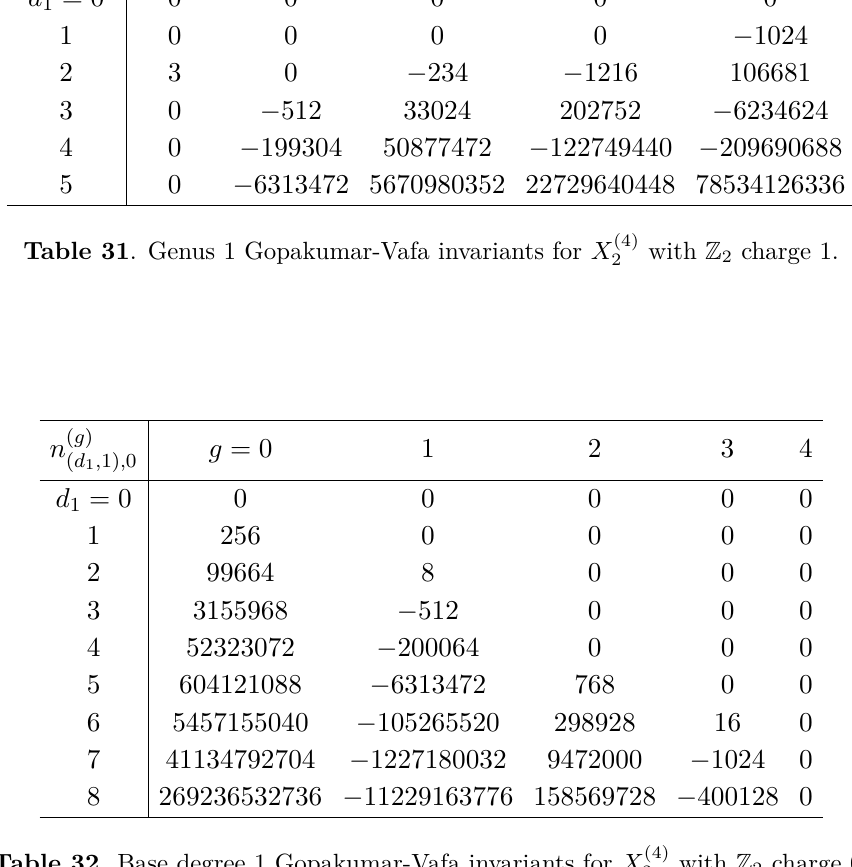
Table 32 . Base degree 1 Gopakumar-Vafa invariants for X (4)